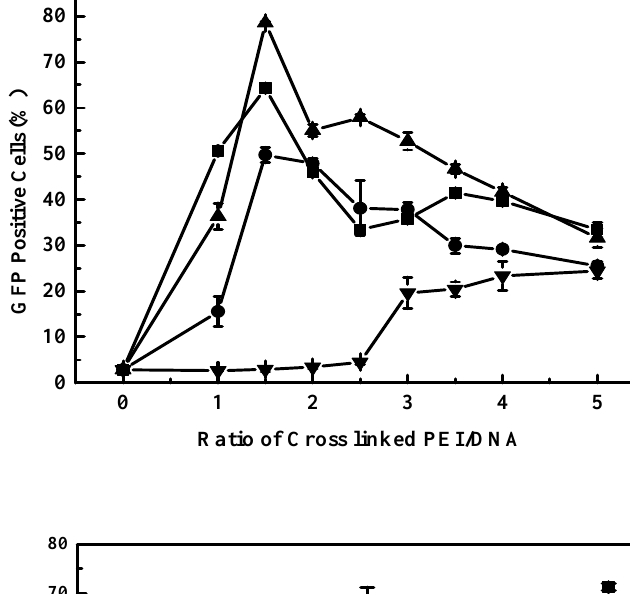
Figure 3. Gene transfection and expression efficiency of cross-linked polymers and 25-kDa PEI in different cell lines. Cross-linked PEIs were used to complex 2 µ g DNA (pEGFP-C1) in PBS. The cells were incubated with the complexes for 4 h in serum-free medium, then the cell was incubated for 24 h in normal DMEM medium, and GFP expression was measured. (A) Gene transfection efficiency of 25-kDa PEI in 293 T, P19, 3T3 and Jurkat cells. (B) Gene transfection efficiency of 25-kDa PEI or cross-linked polymers in 293T cells. - ■ - : 25-kDa branched PEI; - ● - : BDDA-PEI 2000-4h; - ▲ - : EGDMA-PEI 2000-4h. *, p < 0.01 as compared to 25-kDa branched PEI . (C) Gene transfection efficiency of 25-kDa PEI or cross-linked polymers in 3T3 cells. - ■ - : 25-kDa branched PEI; - ● - :